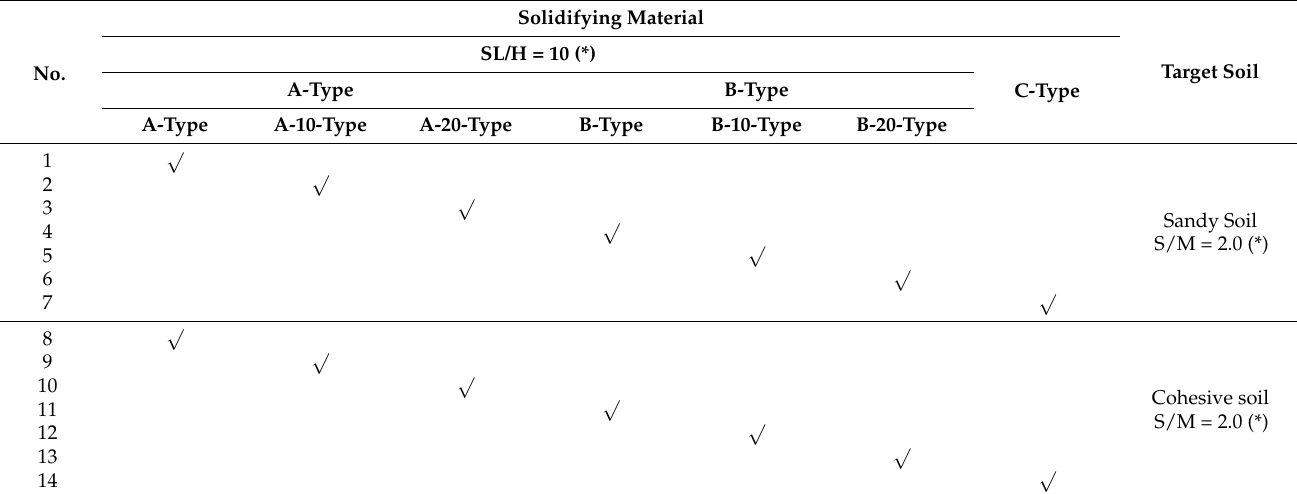
Table 1. Conditions of specimen mixing in each interior mixing